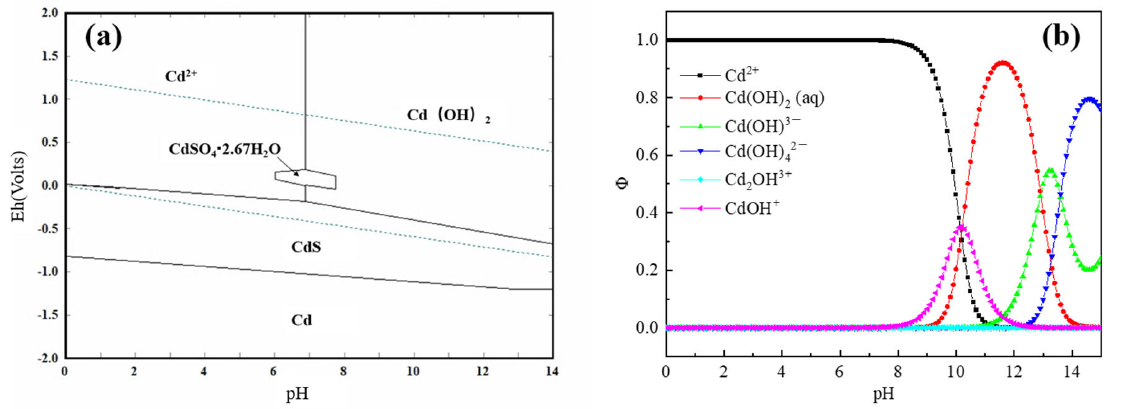
Figure 4. ( a ) Eh ‐ pH diagram of the Cd ‐ S ‐ H 2 O system at 25 °C; ( b ) Ion species and contents of Cd ‐ Figure 4. ( a ) Eh-pH diagram of the Cd-S-H 2 O system at 25 ◦ C; ( b ) Ion species and contents of Cd-H 2 O H 2 O system under various pH ranges. system under various pH